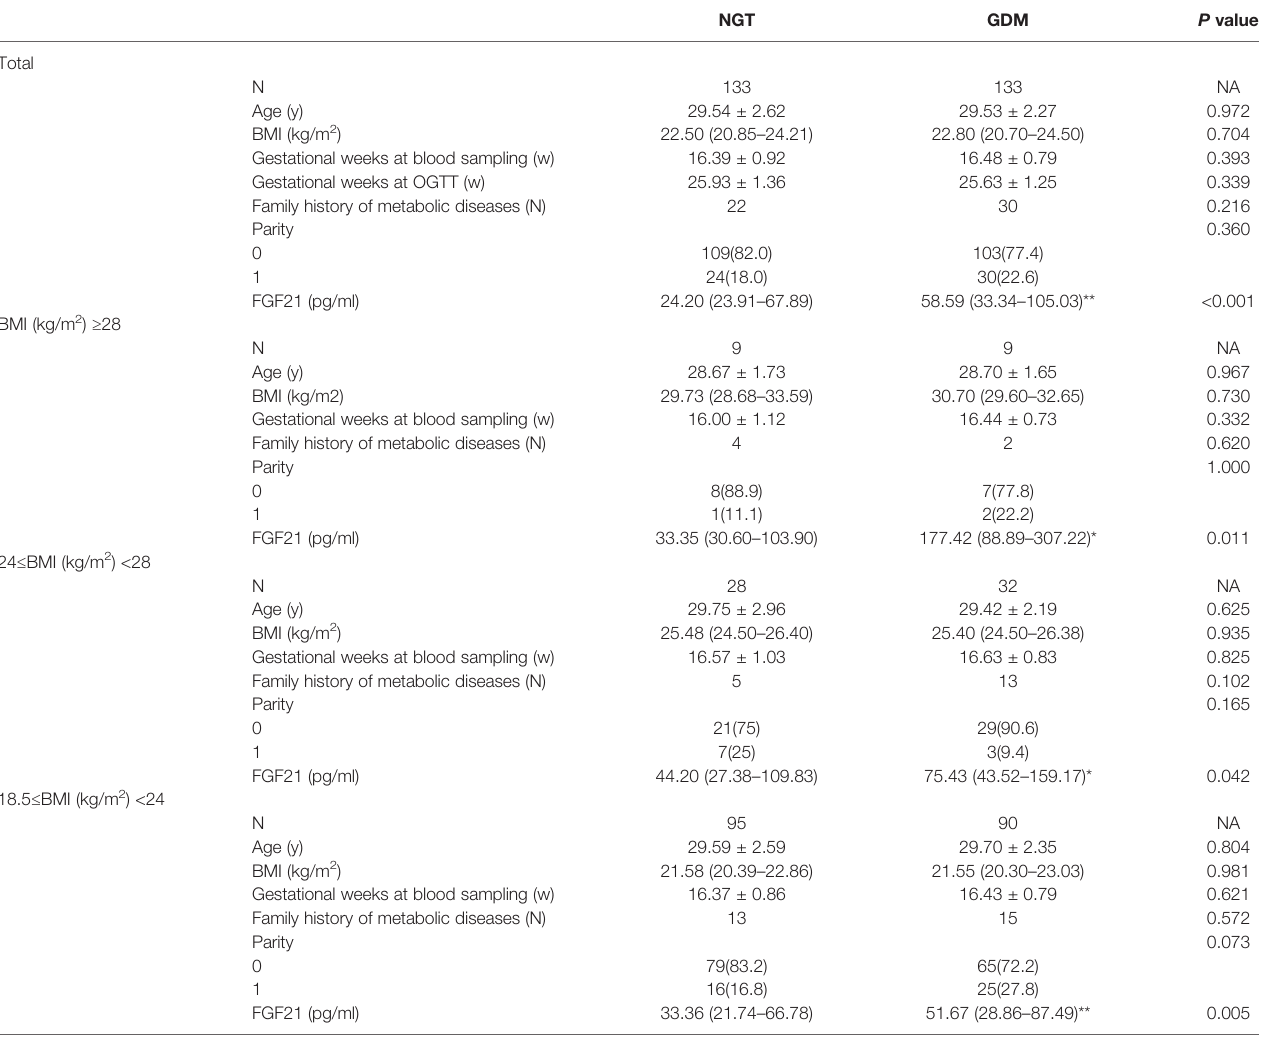
NGT GDM P value